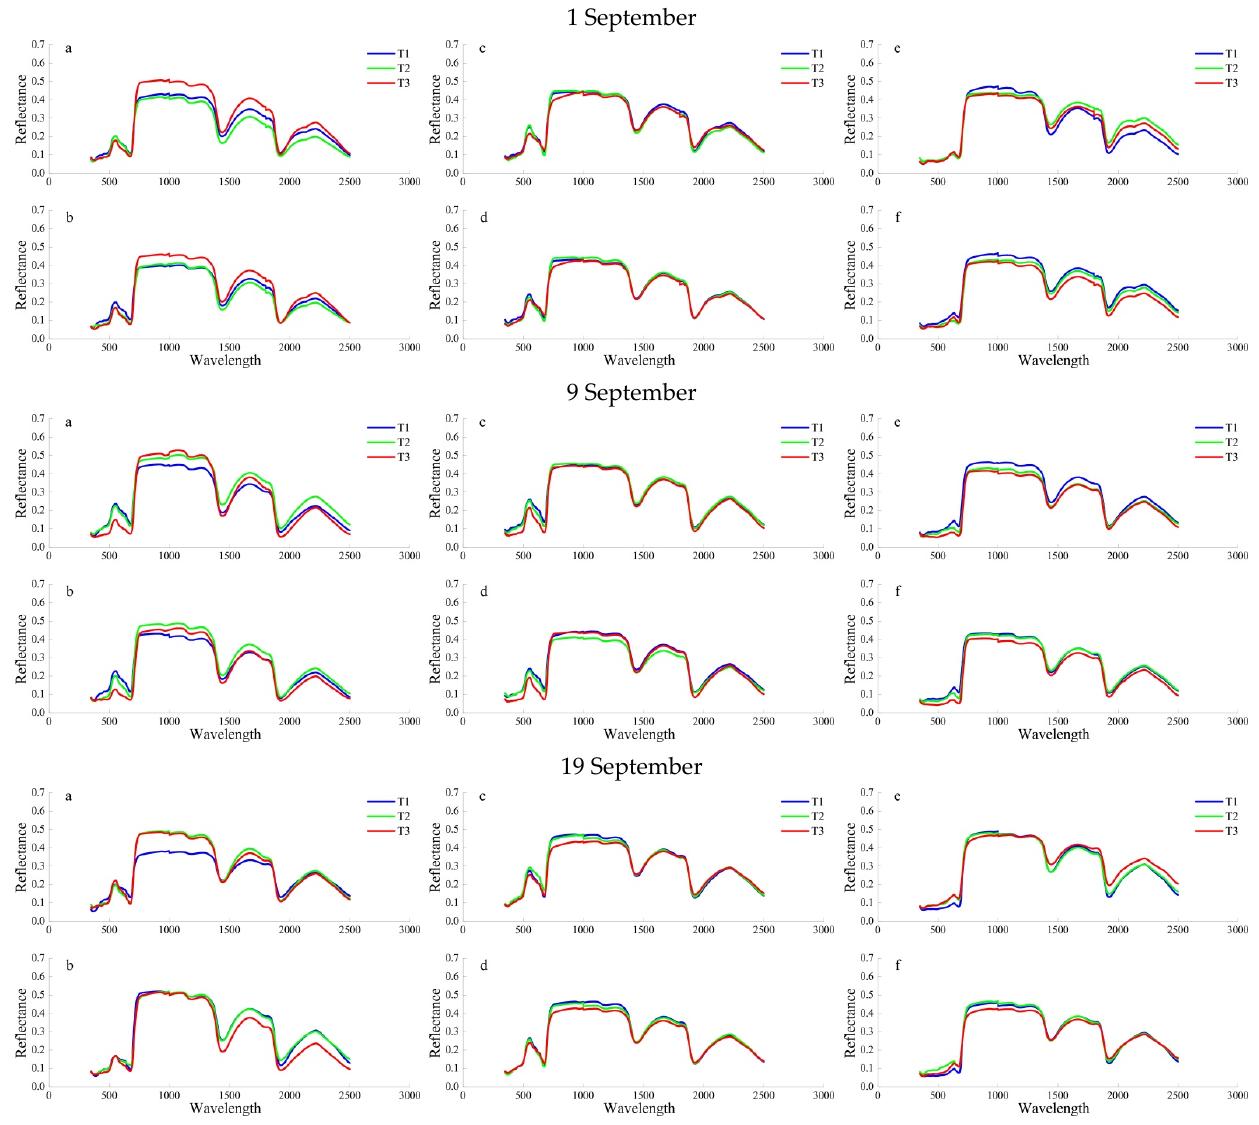
Figure 1. Mean leaf spectral reflectance for three different SO 2 treatments (T1–T3) on 1 September, 9 September, and 19 September 2019 for S. oblate ( a , b ), P. cerasifera ( c , d ) and U. pumila ( e , f ). Bars sharing a common letter are not significantly different ( p < 0.05). Bars represent means ± SE ( n = 9). Figure parts ( a , c , e ) represent the upper 10 days old leaves, and ( b , d , f ) are the lower 40 days old leaves.